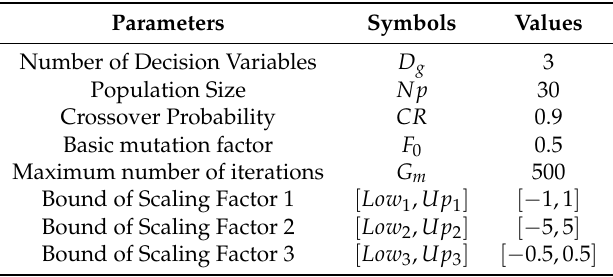
Table 2. The parameter of adaptive mutation differential evolution